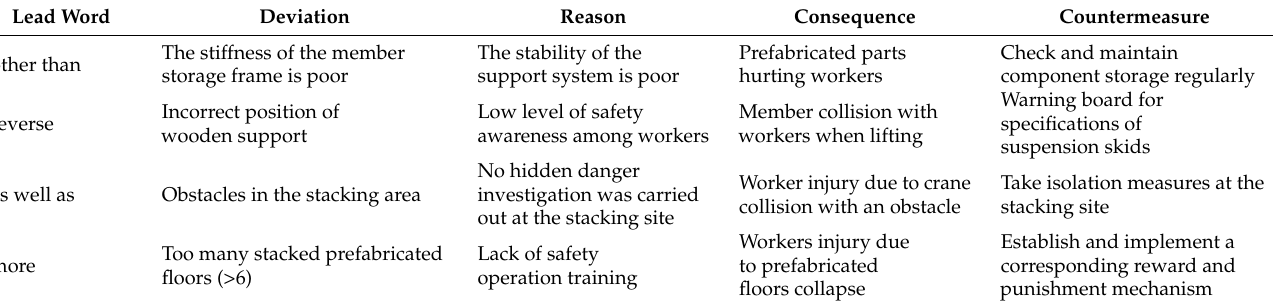
Table 8. HAZOP analysis of the components stacking phase.